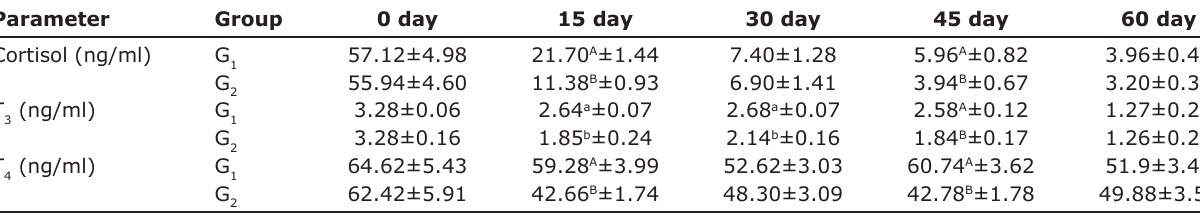
Table-4: Mean±SE of serum hormonal parameters in Vrindavani calves at fortnightly interval.